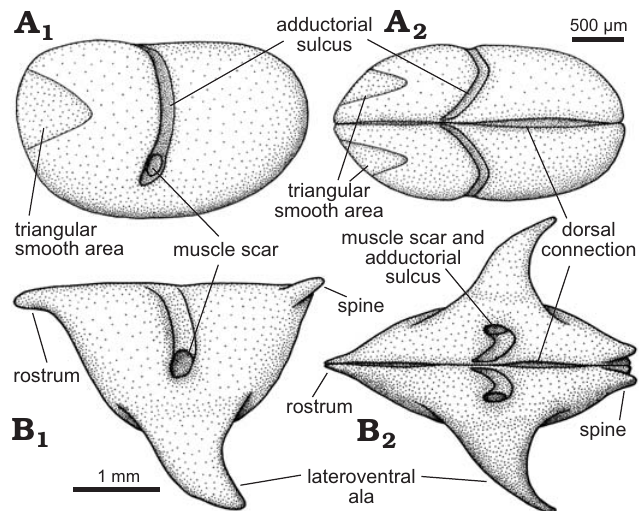
Fig. 7. Idealized reconstructions and terminology of Nudator elegantulus sp. nov. ( A ) and Rhomboentomozoe rhomboidea ( B ) from the Holy Cross Moun tains, Poland; Ludlow Series, Silurian. In left lateral (A 1 , B 1 ) and dor- sal (A 2 , B 2 ) views.